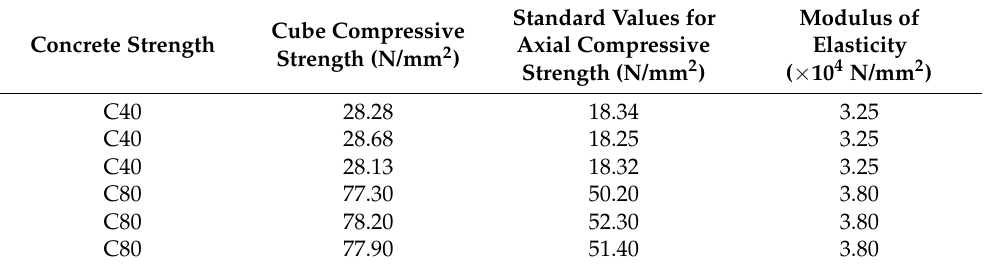
Table 3. Mechanical properties of concrete materials.